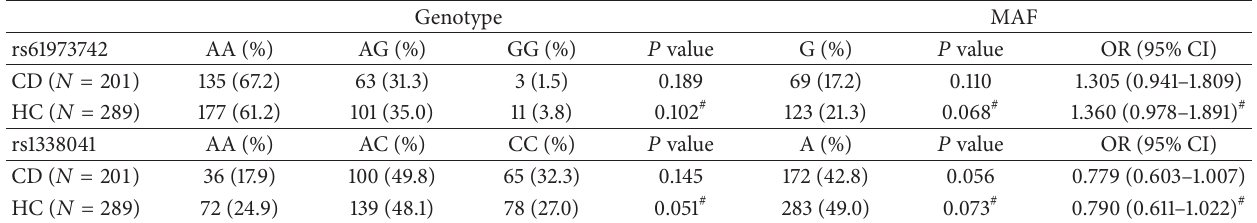
Table 1: Distribution of genotype and allele frequency in cervical dystonia patients and controls.